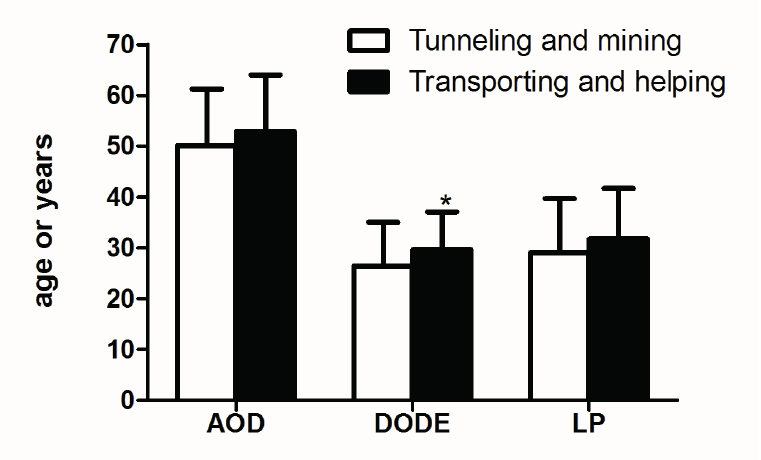
Figure 1. The age of diagnosis, duration of dust exposure and latent period of CWP patients in different job titles. Abbreviations: AOD, age of diagnosis; DODE, duration of dust exposure (years); LP, latent period (years). * p < 0.05 compared with tunneling and mining